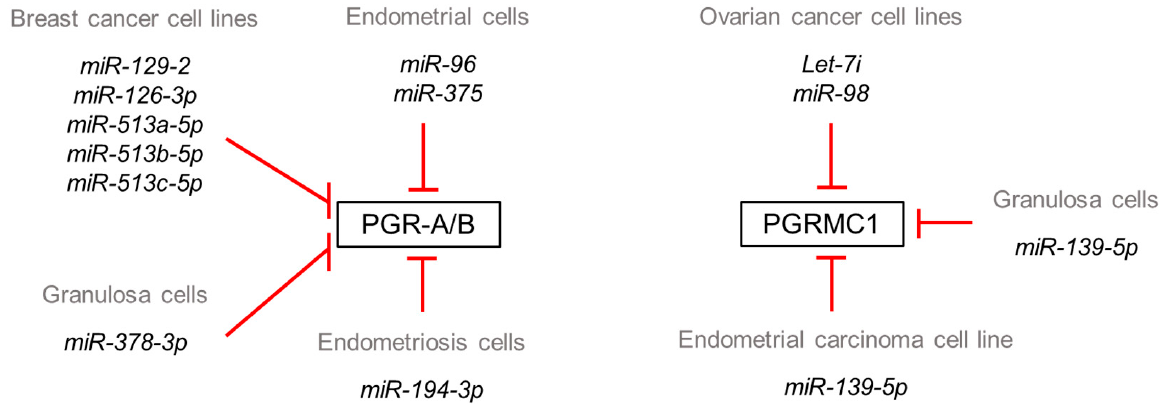
Figure 2. Validated miRNAs which target PGRA/B and/or PGRMC1 in specific cell types. Additional studies have revealed that miR-378-3p regulates PGR expression in ovar- Receptor expression, confirming it as a target of miR-513a-5p. miRNA profiling, was ian granulosa cells [62], while in non-human primate endometrial tissue, PGR is a valid target of miR-96 in rhesus monkeys as well as in humans but not in rodents, whereas the regulation of PGR by miR-375 is rhesus monkey-specific [63]. With respect to endometrio- sis, Zhou and colleagues [64] demonstrated that miR-196a targeted PGR expression in endometrial stromal cells. Of interest was the observation that although miR-196a is pre- dicted to target PGR , 3 (cid:48) UTR reporter assays failed to confirm miRNA binding. It was revealed that miR-196a’s down-regulation of PGR occurred indirectly via the modulation of MEK/ERK. miR-194-3p was also reported to be increased in the eutopic endometrium from women with endometriosis which was associated with reduced PGR levels [65]. Further, PGR was identified by luciferase reporter assays as a direct target of miR-194-3p and its overexpression in stromal cells inhibited in vitro